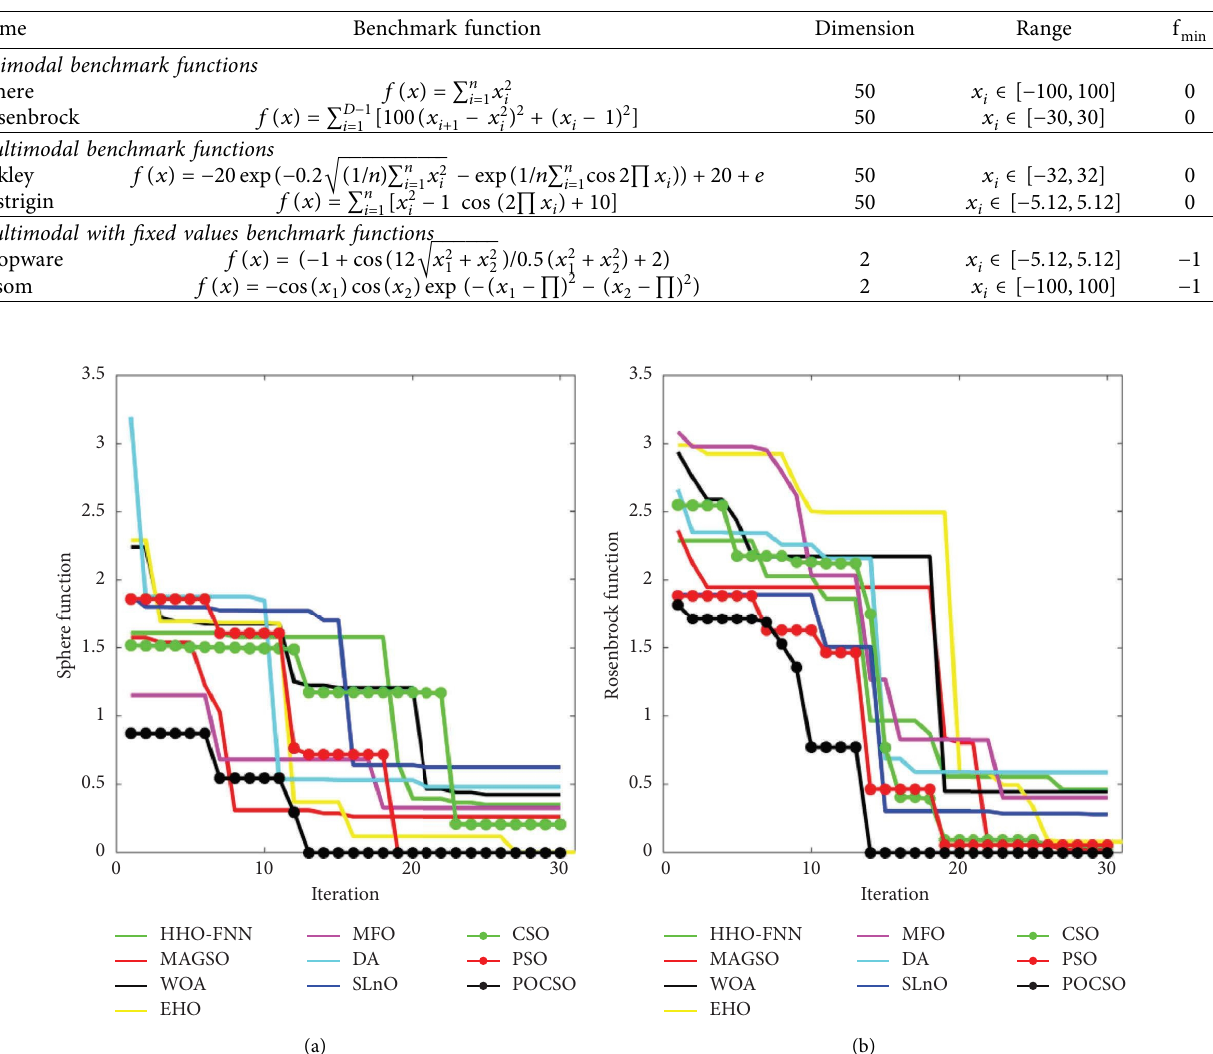
Figure 9: Convergence analysis of the proposed POCSO and extant methods for unimodal benchmark functions such as (a) sphere and (b)